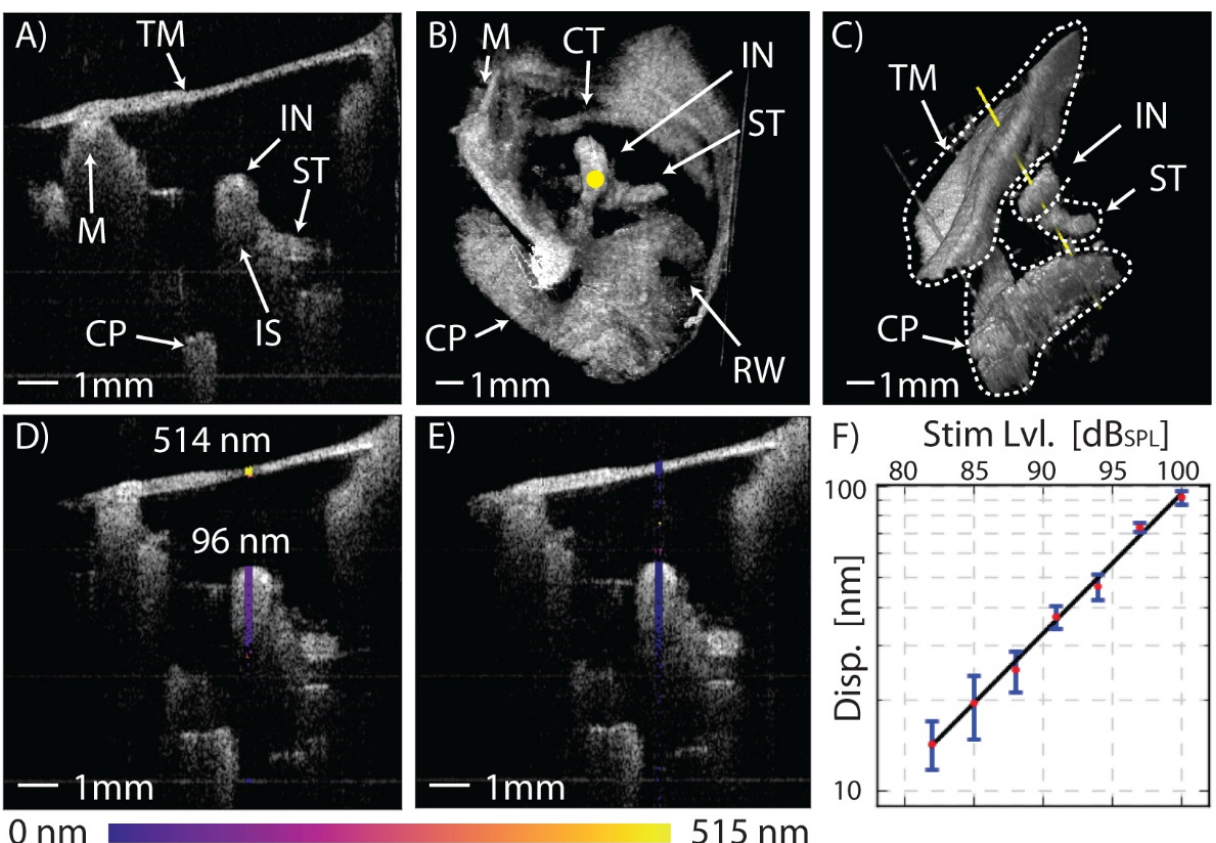
Figure 7. In vivo, real-time functional imaging of a normal left ear’s response at 1030 Hz. ( A ) A 1 × 1 cm 2 2D cross-section of the middle ear in the transverse plane. ( B ) A 1 × 1 × 1 cm 3 3D volume render of the middle ear as seen from the perspective of the ear canal with the TM digitally removed, and ( C ) from an inferior-posterior perspective with the TM in place showing the axis of Doppler measurement along the yellow line passing through the incus at the stapedius tendon. Functional measurements of the TM and incus’ peak-to-peak vibrational response at 1 kHz ( D ) with a 100 dB SPL tone applied to the ear and ( E ) without a stimulus. ( F ) Plot of the displacement response versus the sound pressure level showing excellent linearity from 80 dB SPL to 100 dB SPL. Error bars represent ± one standard deviation of the response over the pixels along the axial length of the incus. Tympanic membrane (TM), malleus (M), incus (IN), incudo-stapedial joint (IS), stapedius tendon (ST), chorda tympani nerve (CT), cochlear promontory (CP), round-window niche (RW). Reprinted with permission from Ref. [49]. © The Optical Society.